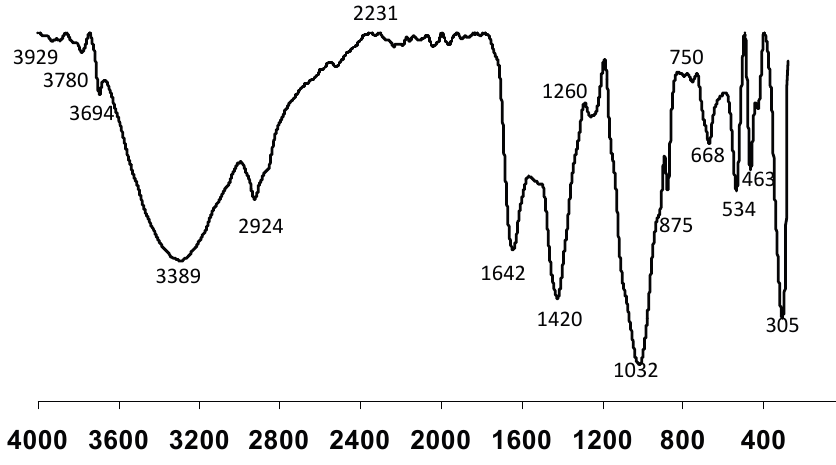
Figure 4. The FTIR spectrum of paper mill